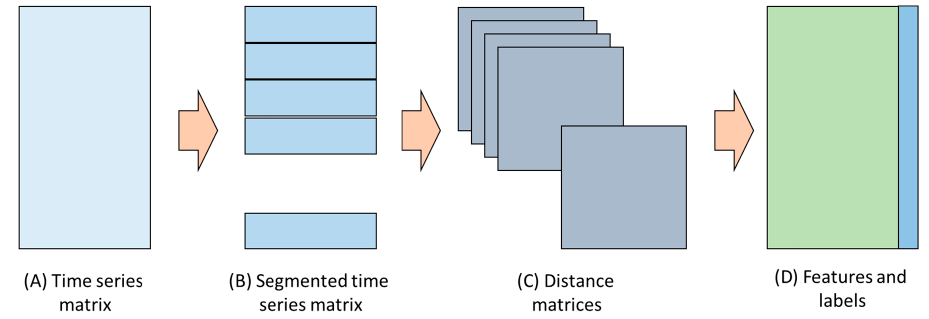
Figure 1. Schematic workflow of the study, comprising the time series data (A), segmentation of the data (B), calculation of distance matrix for each time series segment (C), and extraction of texture features from each matrix (D) from which models can be built to relate the features to the descriptive labels associated with the time series data.